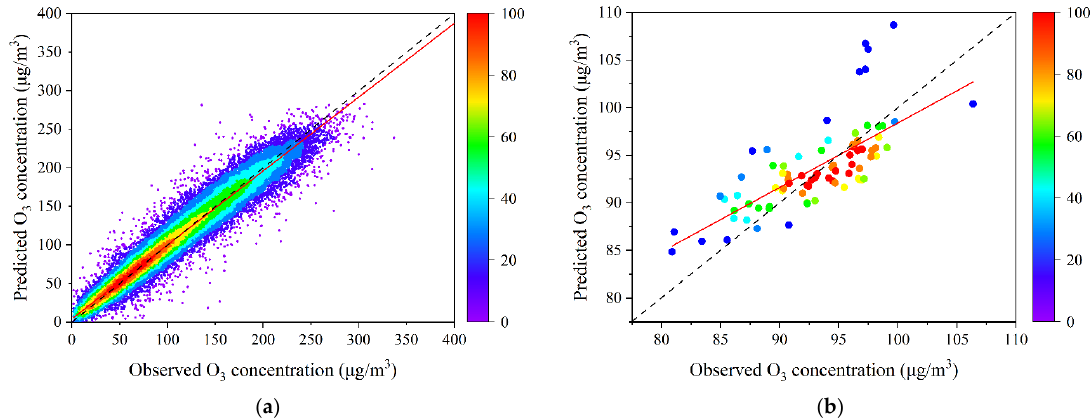
Figure 3. Fitting scatter plots of the GWR model cross-validation results for the short- ( a ) and long-term ( b ).